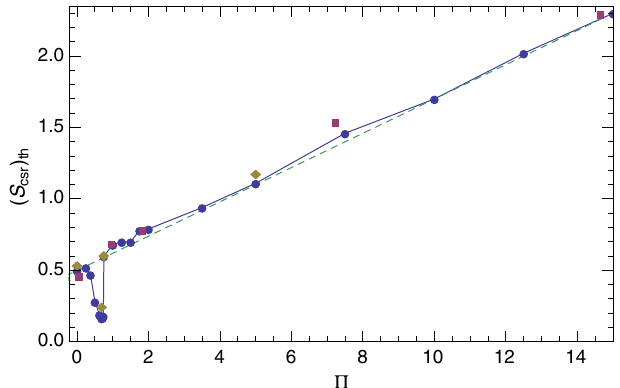
FIG. 2. For the Q ¼ 1 resonator, the Haı¨ssinski solution at threshold, for the cases (cid:4) ¼ 0 : 5 ; 1 : 0 ; 1 : 5 ; 2 : 0 . Note that the bunch head is to the right.